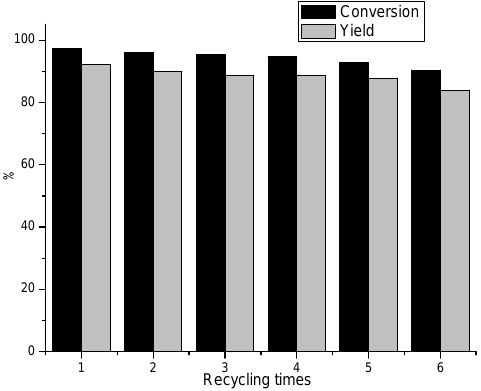
Figure 3. Recycling of Ni/C catalyst. Conditions: 160 °C, 17 h, 1 MPa H 2 , 1 g cyclohexanol, 1 g 10 wt % Ni/C catalyst, 28 g (25 wt %) aqueous ammonia.